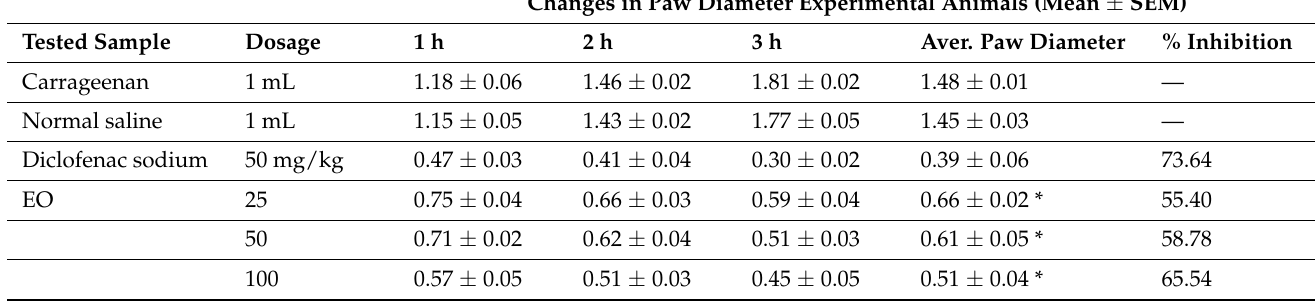
Table 3. Anti-inflammatory capabilities of ELEO.